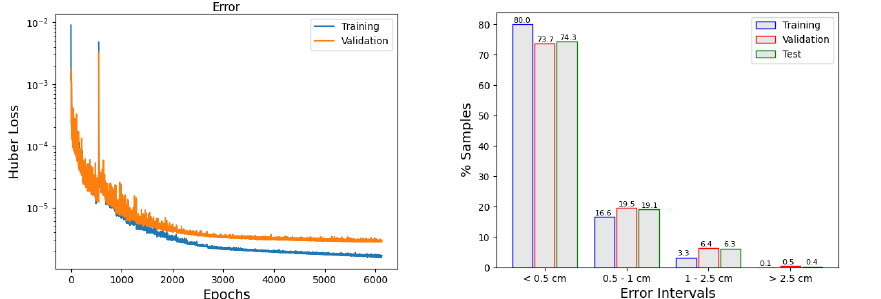
Figure 8. Train and validation error during training ( left ) and percentage of predictions in certain error intervals in the maximum height problem ( right ).